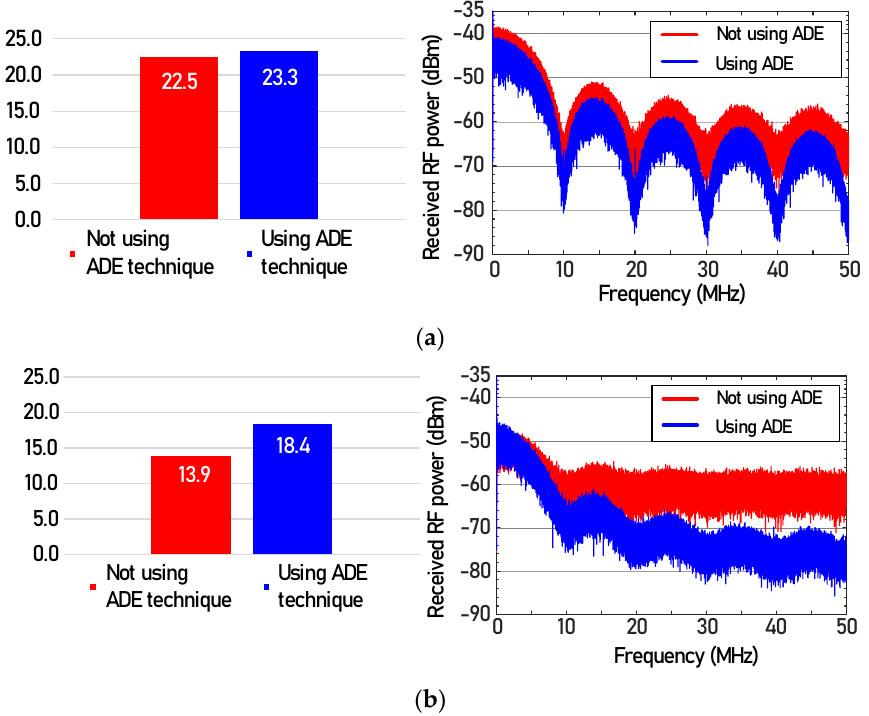
Figure 3. Signal − to − noise ratio (left) and RF spectrum (right) of NRZ − OOK signal before and after using ADE technique, ( a ) in case of transmitting only white LED light, ( b ) in case of transmitting fluorescent lamp, and dimmable LED as well as white LED light.